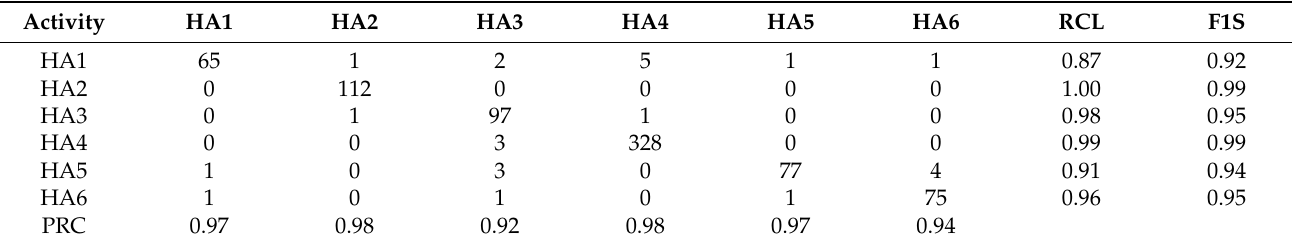
Table 3. Confusion matrix for the proposed model on our